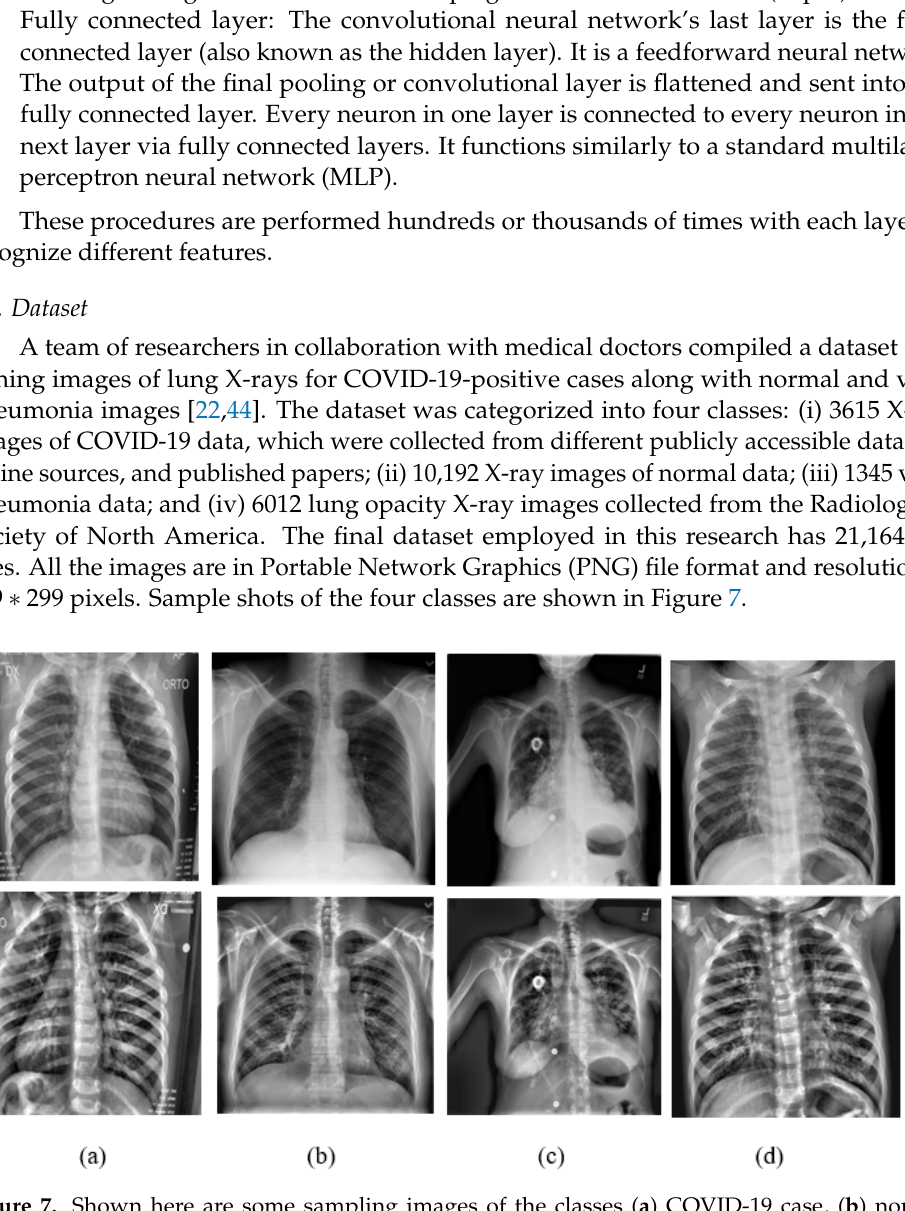
Figure 7. Shown here are some sampling images of the classes ( a ) COVID-19 case, ( b ) normal case, ( c ) viral pneumonia, and ( d ) lung opacity. The original images are in the first row and the corresponding CLAHE images are in the second